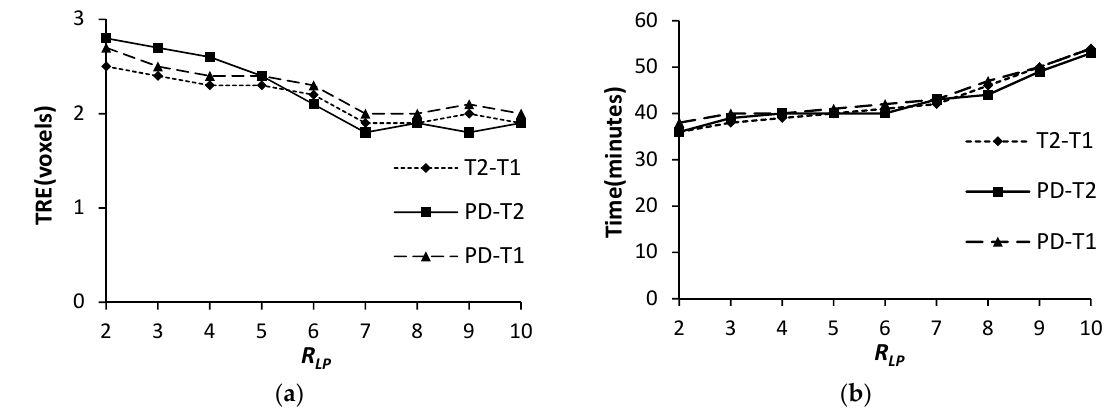
Figure 6. The TRE and computation time with different R